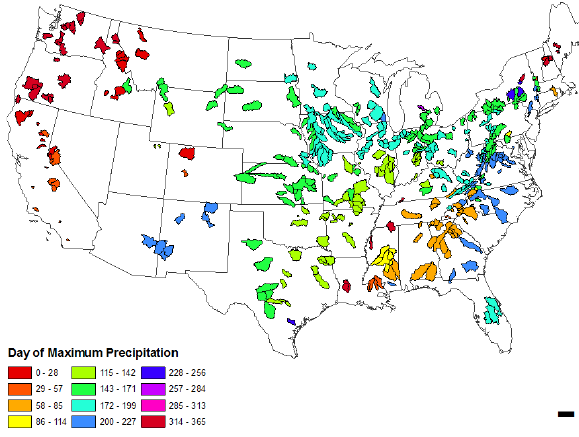
Fig. 3. Spatial distribution of the seasonality index. Fig. 4. Spatial patterns of the day of peak precipitation day